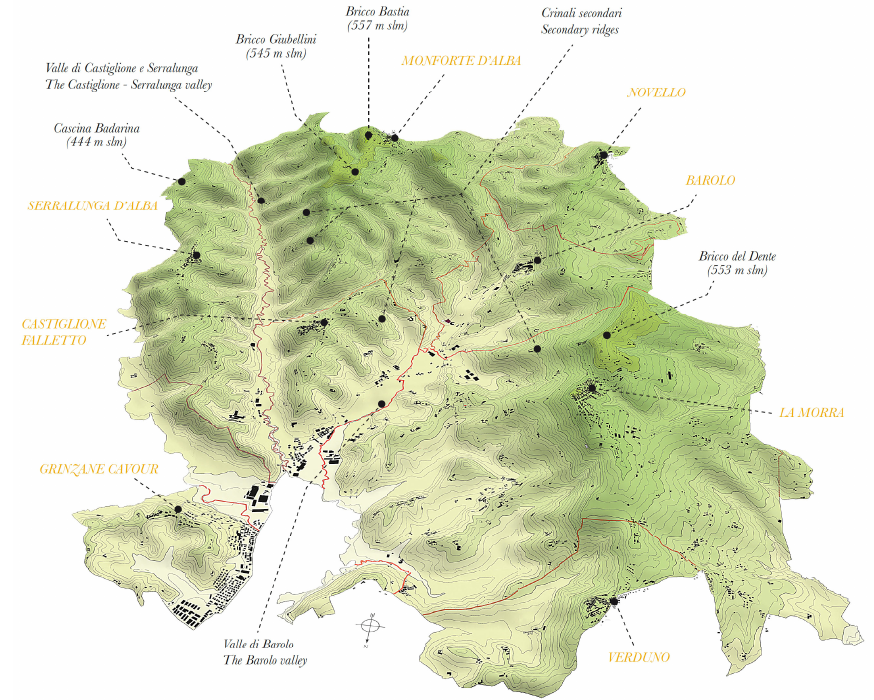
Figure 1. The study area (about 8000 ha) includes 2100 ha of vineyards planted with cv. Nebbiolo for the production of the premium wine “Barolo DOCG. Figure courtesy of Alessandro Masnaghetti Editore ENOGEA [50].